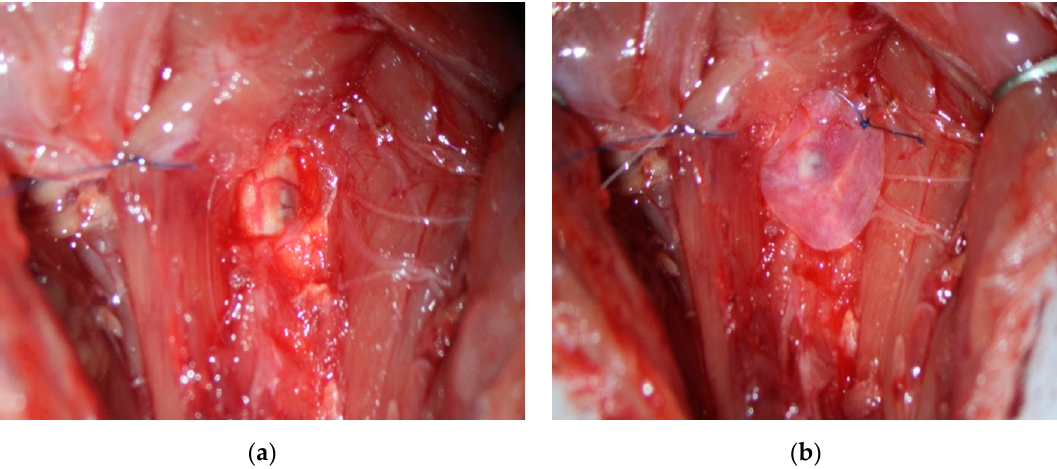
Figure 2. Surgical implantation of PMSCs seeded on an extracellular matrix scaffold (SIS-ECM) to a rat C5 spinal cord hemicontusion model. ( a ) Contused spinal cord visible after C5 hemilaminectomy and impact in an adult rat. ( b ) Placement of PMSCs seeded on SIS-ECM scaffold directly placed onto spinal cord after dura was opened.